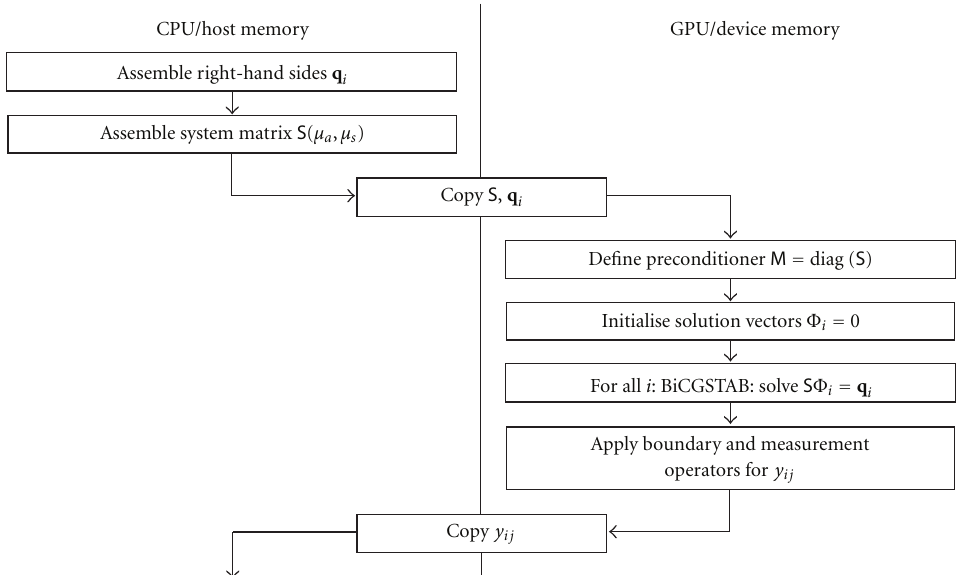
Figure 1: Data flow between host and graphics device for solution of linear problem